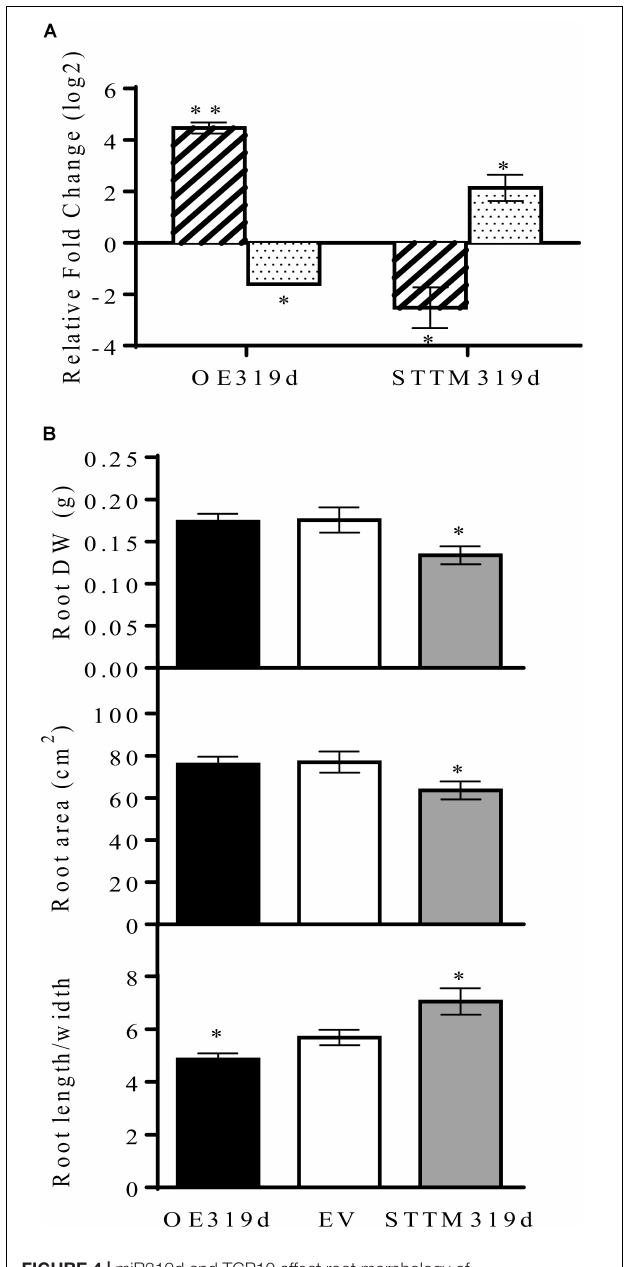
FIGURE 4 | miR319d and TCP10 affect root morphology of R. tropici -inoculated common bean plants. (A) Transcript levels of mature miR319d (diagonally striped histograms) and TCP10 (dotted histograms) were determined by qRT-PCR in 24 dpi inoculated roots of composite plants transformed with OE319d or STTM319d constructs. Values (log 2 ) were normalized to the value from control or EV-transformed inoculated roots that was set to 0. Values represent means ± SD from three biological replicates and two technical replicates each. (B) Roots dry weight (DW), area and length/width ratio from composite bean plants with transgenic roots overexpressing (OE319d, black histograms) or silencing miR319d (STTM319d, gray histograms) as compared with control roots (EV-transformed, white histograms). Values represent means ± SD from nodulated roots of sixteen to twenty independent composite plants each. The Mann–Whitney null hypothesis statistical test is relative to EV control data ( ∗ and ∗∗ represent a p- value < 0.05 and p- value < 0.01,